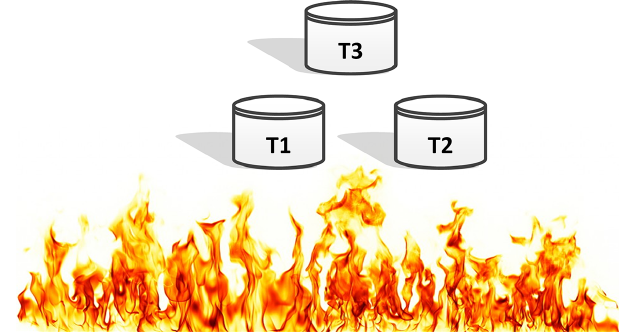
Figure 10. An exemplary storage plant exposed to the heat of wild-